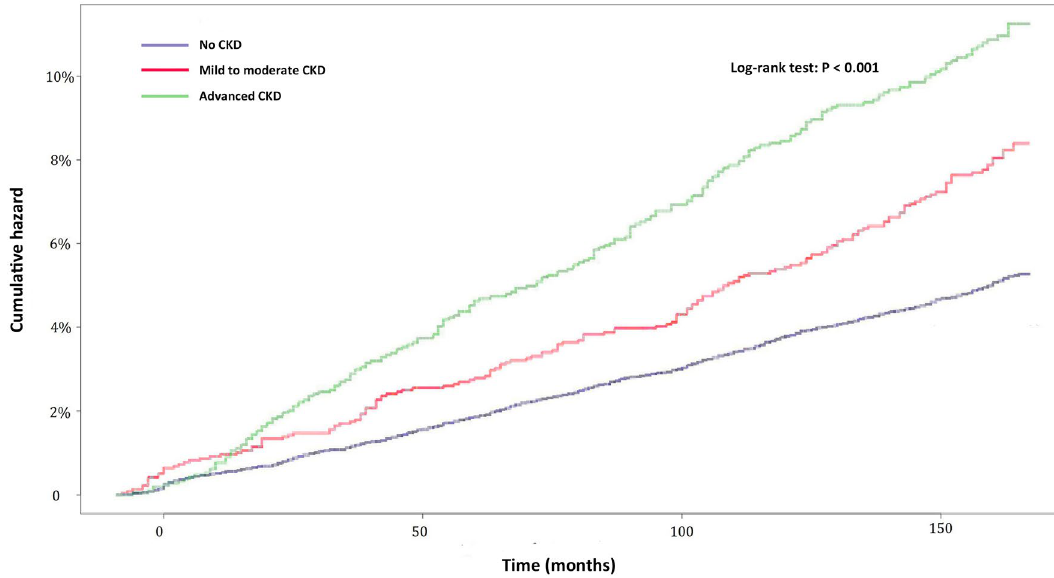
Figure 2. Cumulative hazards of open-angle glaucoma in CKD patients with stage 1–2 (mild to moderate CKD) and stage 3–5 (advanced CKD) by month.